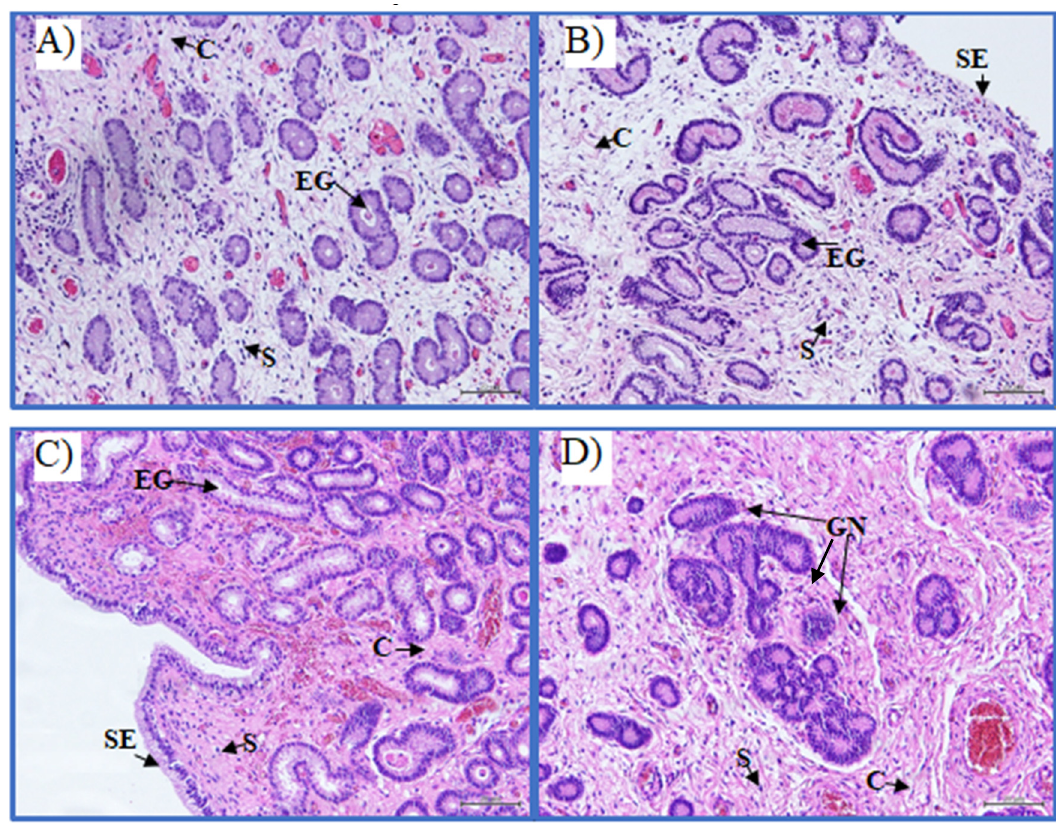
Figure 7. Representative equine endometrial biopsies classified as category IIA ( A , B ) and IIB ( C , D ) according to Kenney and Doig (1986) classification. Endometrial glands (EG), glandular nests (GN), collagen fibers (C), stromal cells (S), surface epithelium (SE). Staining with hematoxylin and eosin. Scale bar = 20 µm.